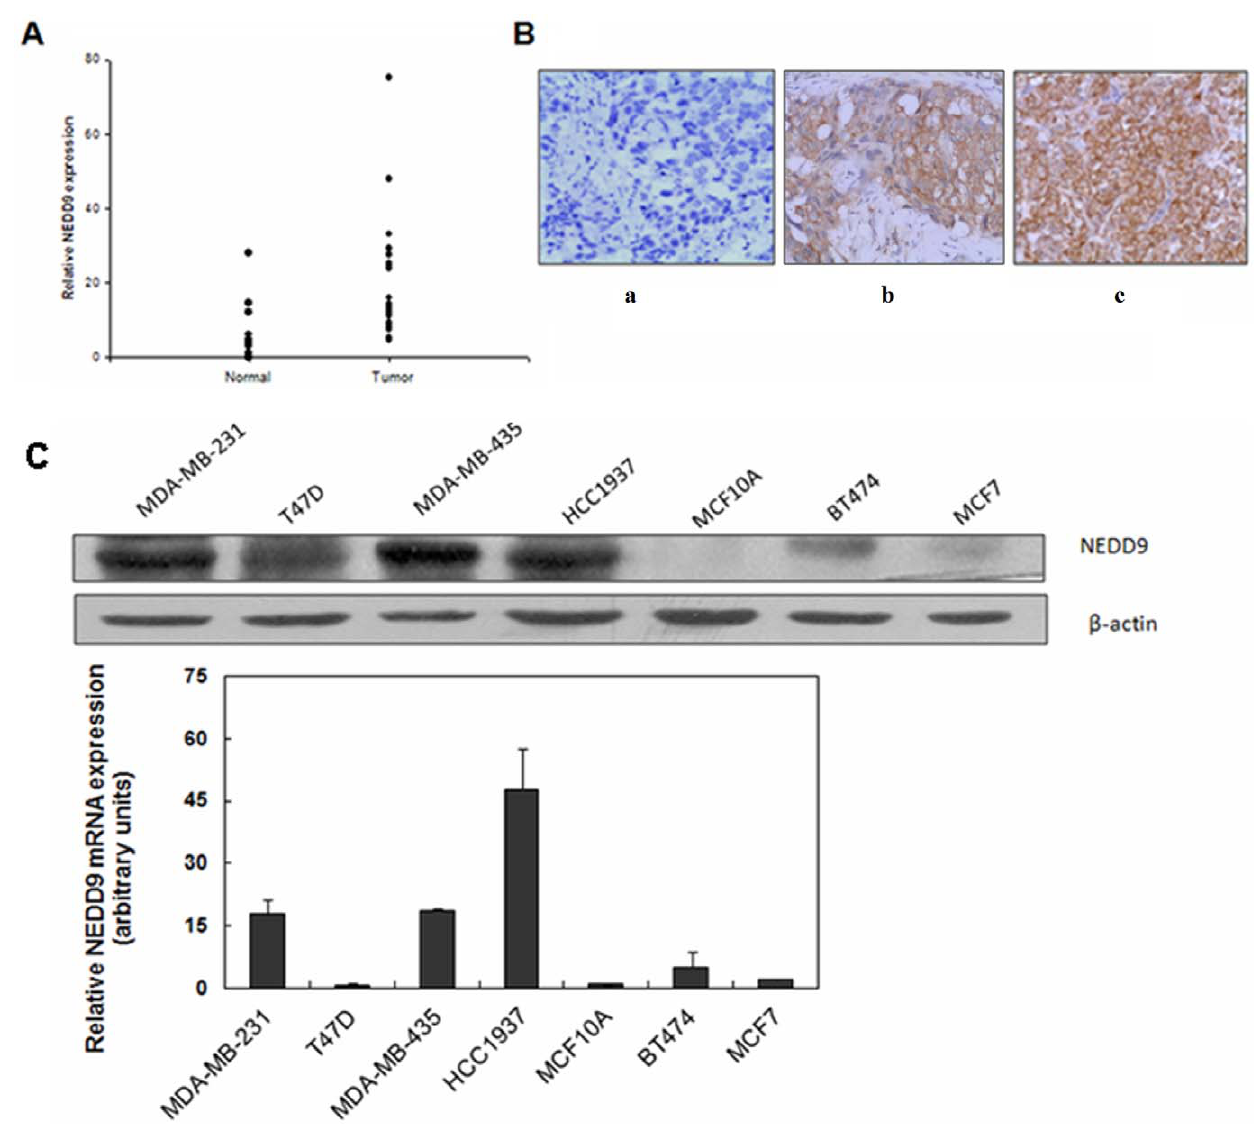
Figure 1. Expression of NEDD9 in breast tissue samples. A, NEDD9 levels in normal breast and breast cancer tissues. Normalized NEDD9 mRNA expression was measured by quantitative RT-PCR with b -actin expression as the internal control. B, Representative IHC of NEDD9 protein expression in paraffin-embedded human primary breast cancer and adjacent normal tissues. a , faint cytoplasmic staining of NEDD9; b , moderate cytoplasmic staining of NEDD9; and c , strong cytoplasmic staining of NEDD9. C, Western blotting and qRT-PCR analysis of endogenous NEDD9 expression in normal breast epithelial cell lines and in breast cancer cell lines. b -actin was used as a loading reference.